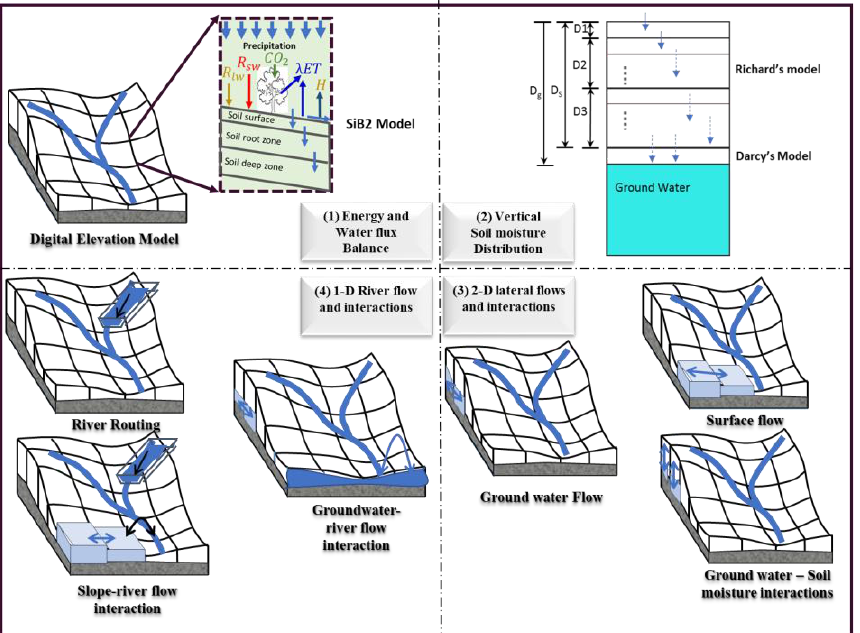
Figure 5. Schematic diagram of the water and energy budget-based rainfall–runoff–inundation (WEB-RRI) model and its four major modules. Reprinted with permission from Ref. [48].